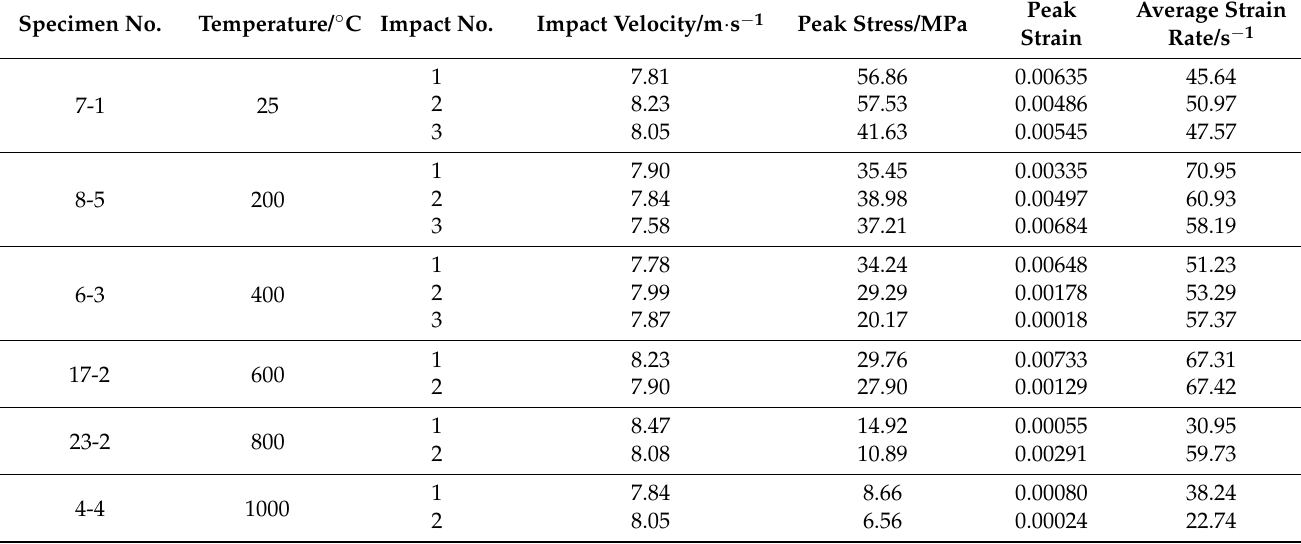
Table 2. Cyclic impact test conditions and results of sandstone after different